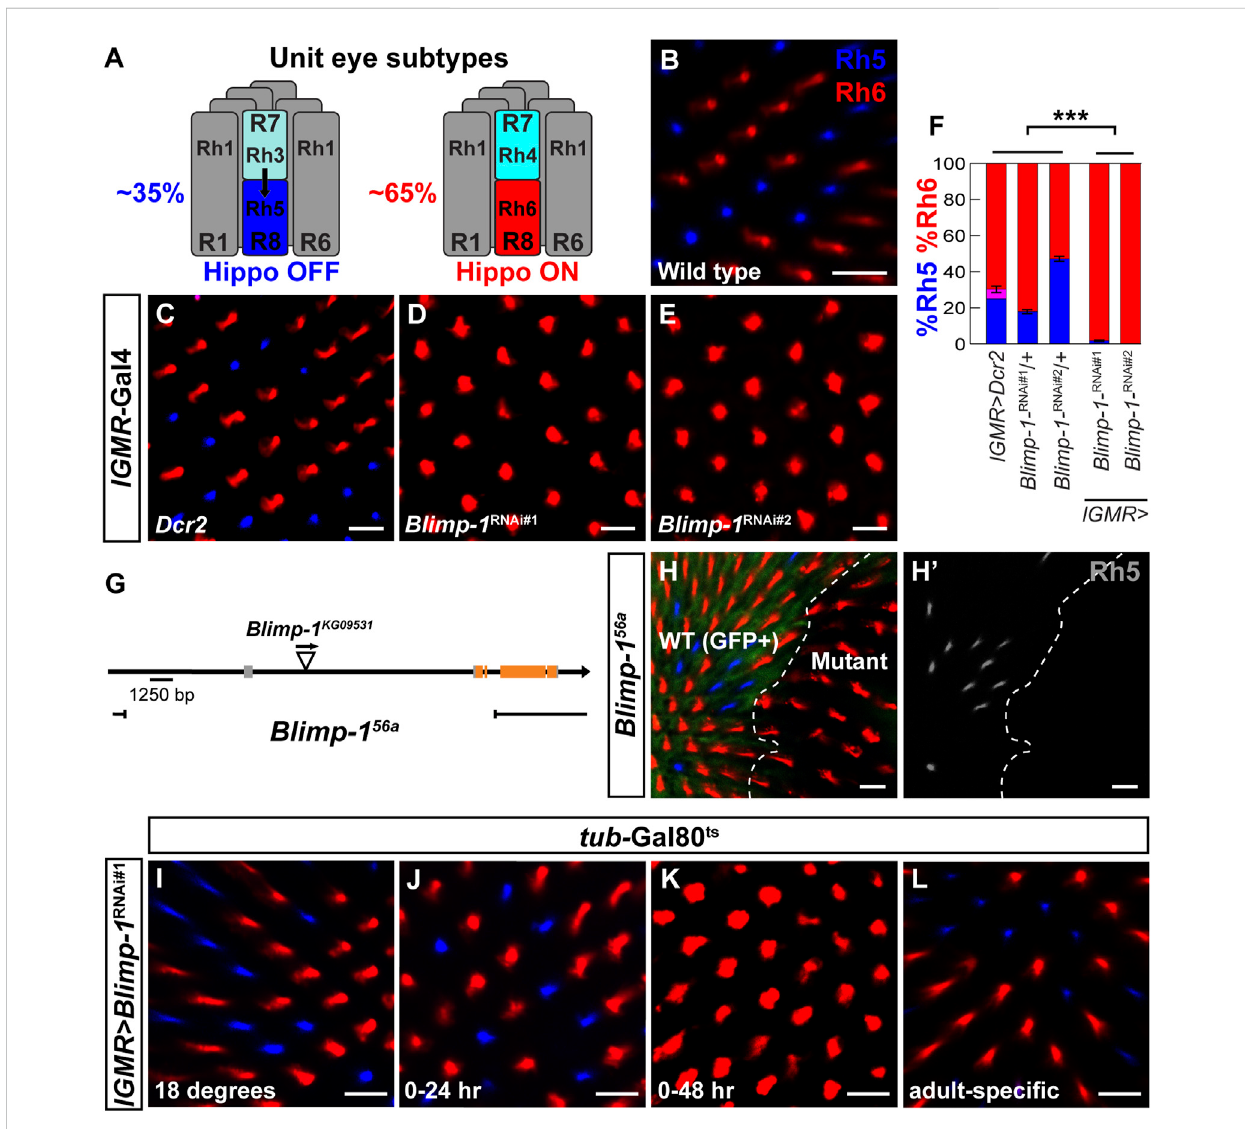
FIGURE 1 Blimp-1 isrequiredto promoteRh5 andtorepressRh6. (A) Schematic sideviewofthetwodifferentuniteyesubtypes inthe Drosophila retina. Black arrow represents the Activin signal from Rh3-expressing R7 photoreceptors (35%, left) that induces Rh5 fate (Hippo OFF) in the proximally located R8photoreceptors.Rh4-expressingR7photoreceptors(65%, right)donotsendtheActivinsignal andthecorrespondingR8photoreceptorsexpressRh6 (Hippo ON) by default. (B – E) Confocal images of whole mounted adult retinas stained with antibodies for Rh5 (blue) and Rh6 (red). (B) A wild-type Canton S retina has an Rh5:Rh6 ratio of ~35:65. (C) Expression of Dcr2 with the pan-photoreceptor driver lGMR-Gal4 does not affect the Rh5:Rh6 ratio. (D and E) Expression of two independent Blimp-1 RNAi constructs, Blimp-1- RNAi kk ( Blimp-1 RNAi#1 ) and Blimp-1- RNAi TRiP #36634 ( Blimp-1 RNAi#2 ), in combination with Dcr2 causes a dramatic loss of Rh5 and a corresponding gain of Rh6. (F) Quanti fi cation of R8 subtypes in controls and Blimp-1 knockdowns. Graph shows the percentage of R8 photoreceptors that express exclusively Rh5 (blue), exclusively Rh6 (red), or co-express Rh5 and Rh6 (magenta).Mean%Rh6wascomparedamonggenotypeswithanANOVAanda posthoc TukeyHSDTest;*** p < 0.0001.7-8retinaswerescoredforeach genotype. (G) Schematic showing the location of the Blimp-1 56a deletion that was generated through imprecise P-element (triangle) excision. (H) Confocal image showing wild type R8 photoreceptors (GFP positive, left) exhibiting a normal Rh5:Rh6 ratio and Blimp-1 56a null mutant clones (GFP negative,right)thatexclusivelyexpressRh6.Thewhitedashedlinedenotestheboundarybetweenwild-typeand Blimp-1 mutanttissue. (H 9 ) Rh5channel (grayscale) shows the loss ofRh5 inthe Blimp-1 mutanttissue. (I – L) Confocal images of temporally restricted lGMR > Blimp-1 RNAi#1 knockdown with tub- Gal80 ts . (I) Control fl iesraisedthroughoutdevelopmentandadulthoodat18 ° C,i.e.,no Blimp-1 knockdown,haveanormalRh5:Rh6ratio. (J) Pupal Blimp- 1 knockdown from 0 to 24 h after puparium formation at 29 ° C does not affect the Rh5:Rh6 ratio. (K) Pupal Blimp-1 knockdown from 0 to 48 h after puparium formation at 29 ° C causes a loss of Rh5 and gain of Rh6. (L) Adult-speci fi c Blimp-1 knockdown for 7 days at 29 ° C following eclosion does not affect the Rh5:Rh6 ratio. All scale bars, 10